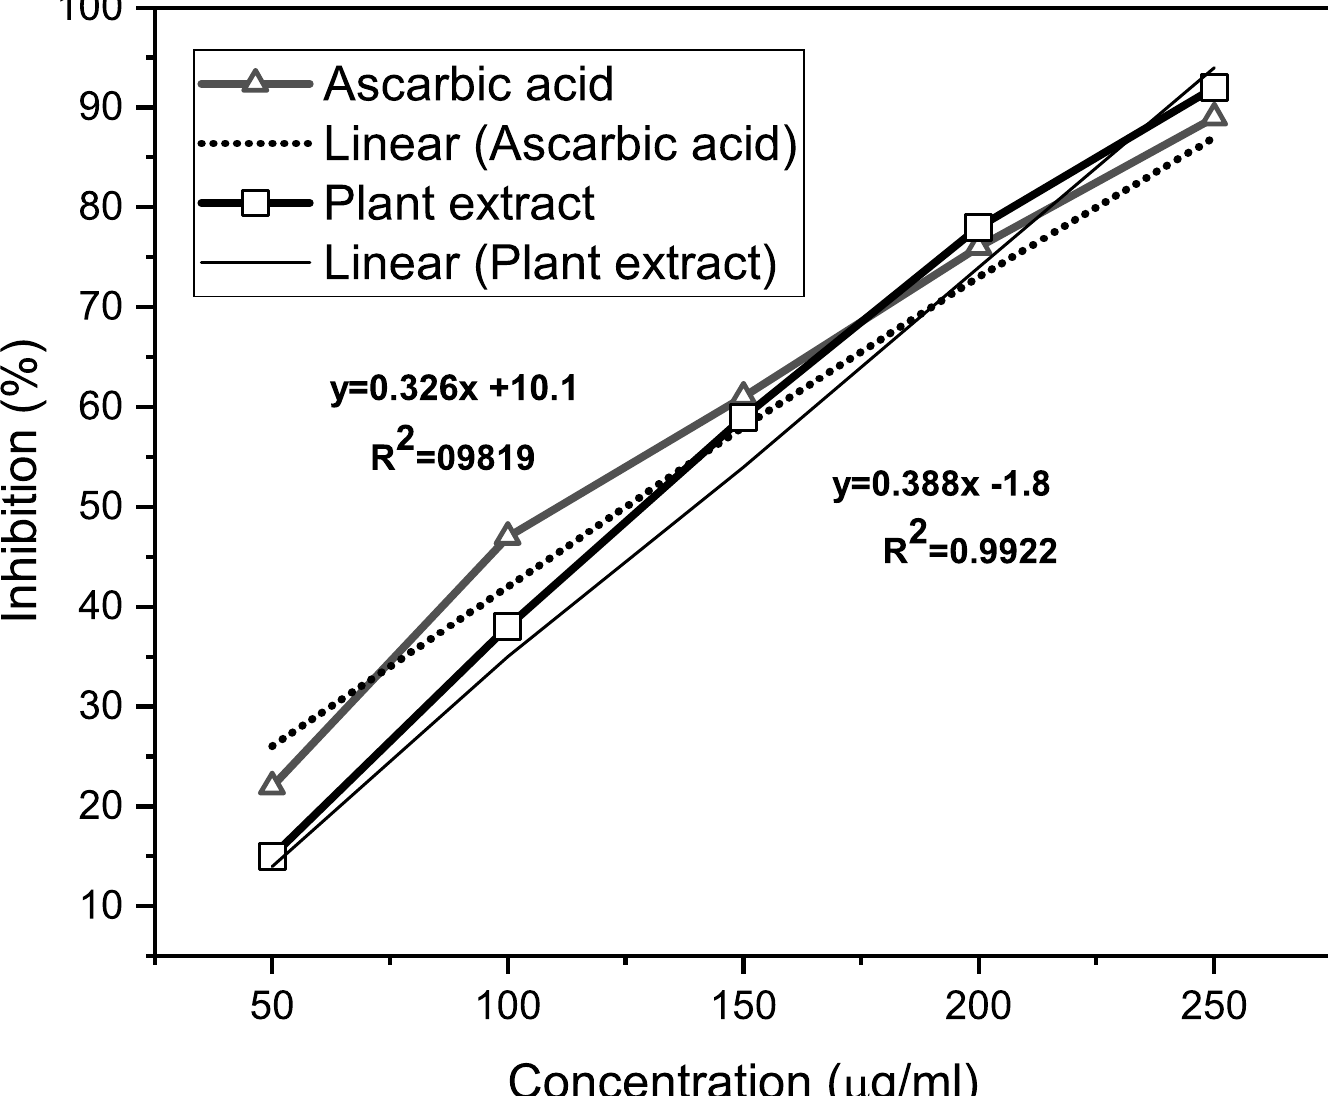
Fig 2. Antioxidant activity (DPPH radical scavenging activity) of S . cumini leaves extract and standard ascorbic acid. Each data point represents the mean of three experiments with standard error of the mean (Mean ± SEM, n = 3).